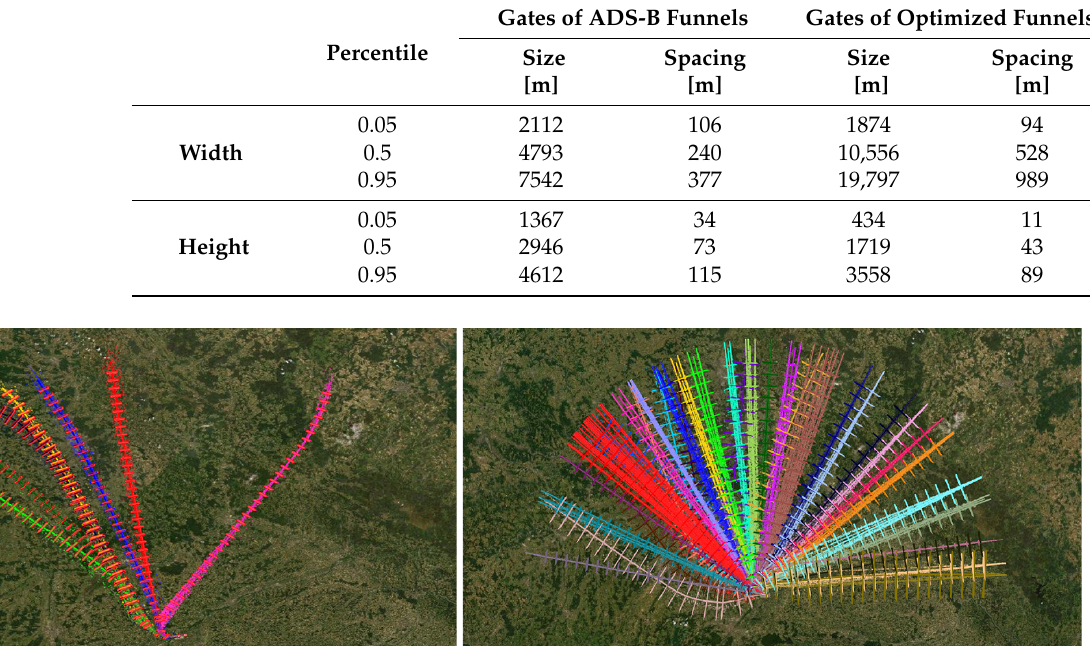
Figure 9. Clustered flight tracks of departing flights using runway 26R at Munich Airport, with the ADS-B clusters excluding outliers on the left and the optimized clusters on the right